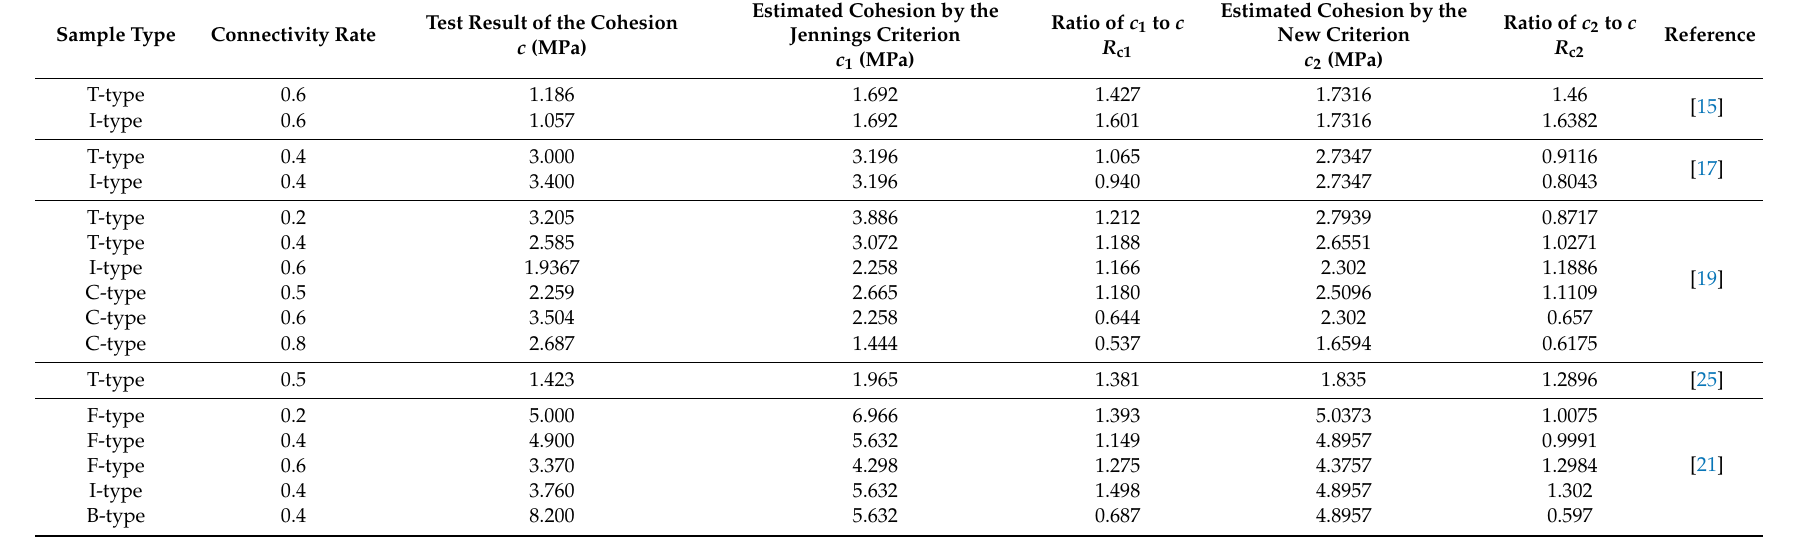
Table 4. Comparison of the cohesions estimated by the Jennings and new